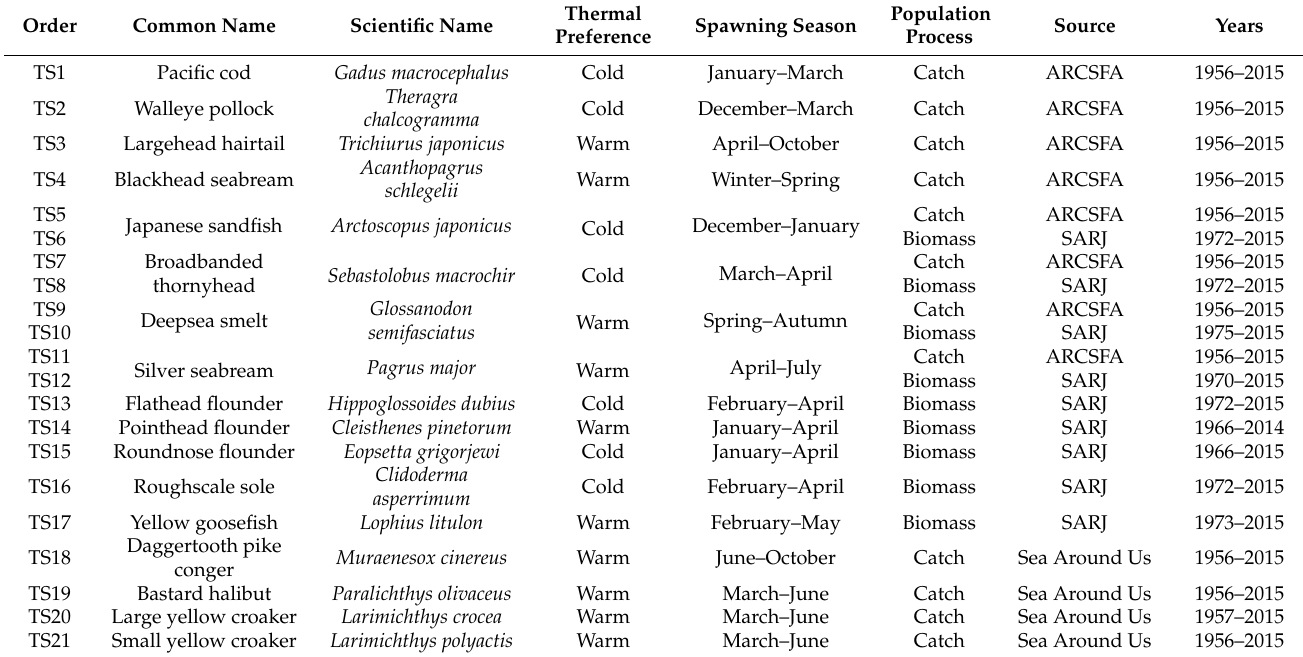
Table 1. Description of the time series of demersal fishes used in our